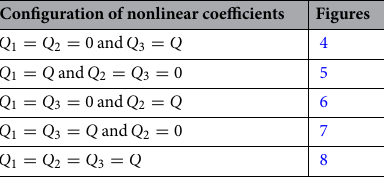
Table 1. Configuration of nonlinear coefficients in the triple waveguide and figure number where the corresponding results are